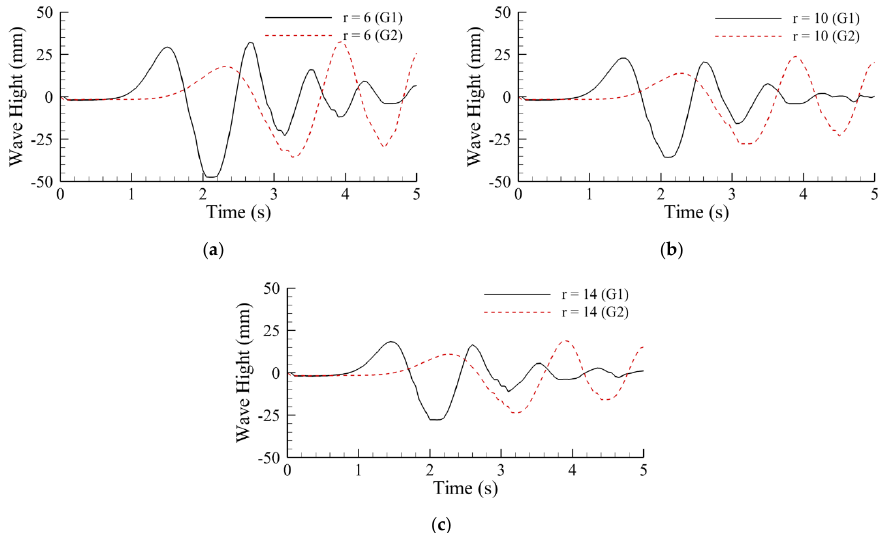
Figure 17. The temporal evolution of water elevation in G 1 and G 2 with the partial subaerial landslide: ( a ) r = 6; ( b ) r = 10; and ( c ) r = 14.